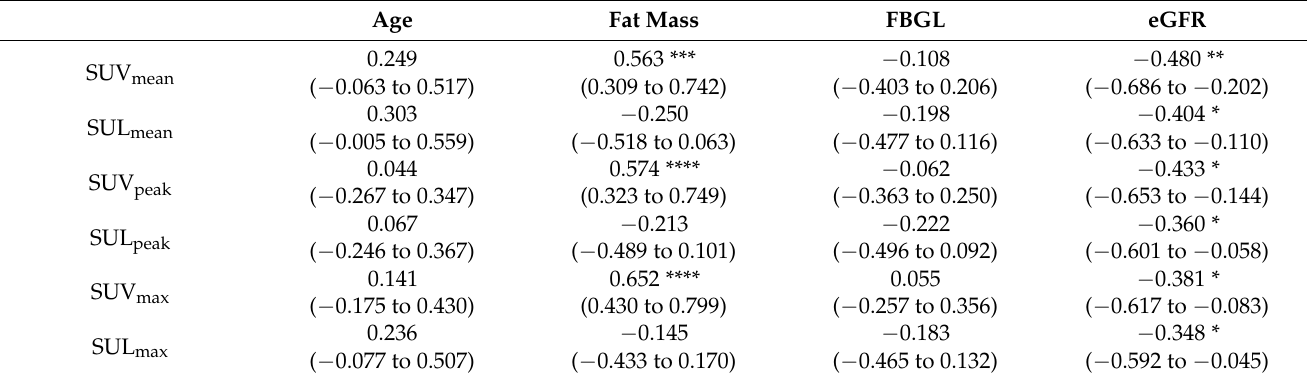
Table 2. Pearson’s correlation coefficients for age, fat mass, FBGL, and eGFR, with the PET activity parameters. The 95% confidence intervals are shown between brackets. Significance of the correlations is denoted by * ( p < 0.05), ** ( p < 0.01), *** ( p < 0.001), and **** p <